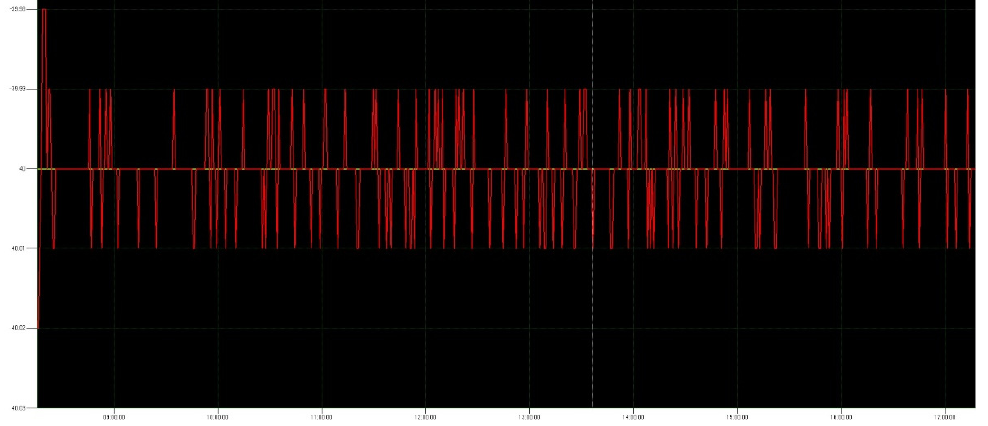
Figure 13. Temperature control system accuracy test result.